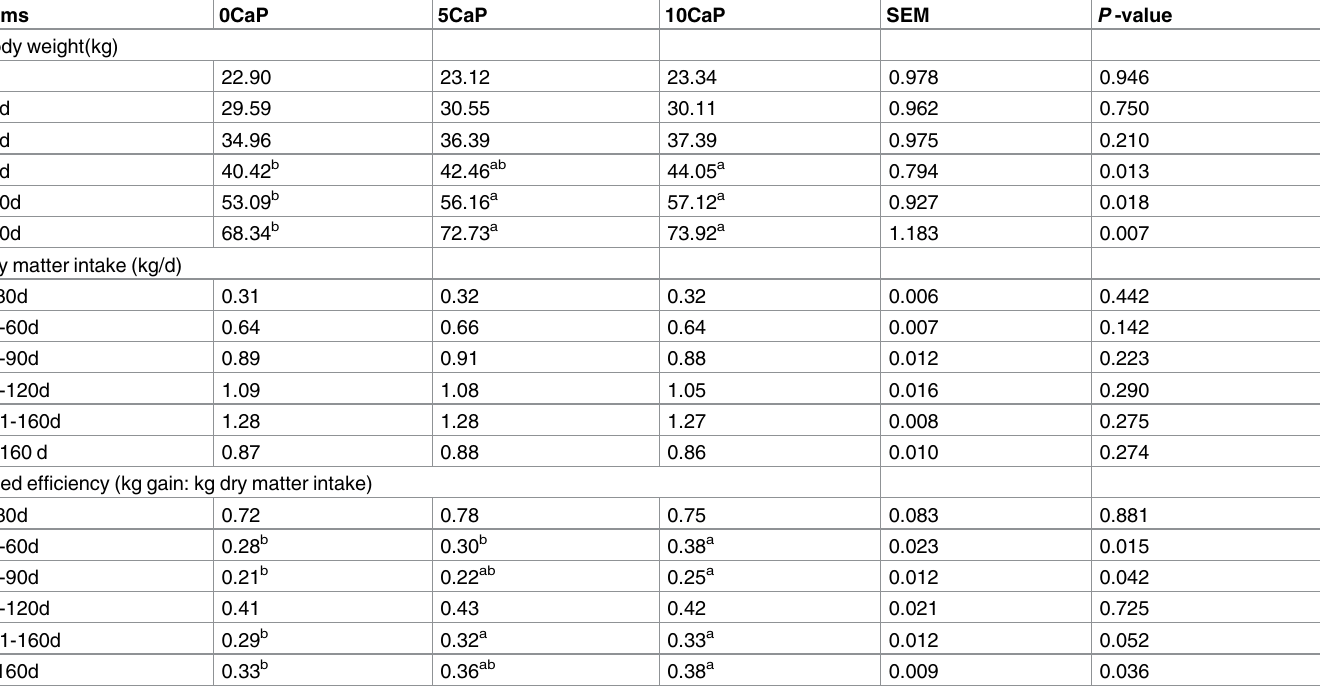
Table 2. The body weight, dry matterintake and feed efficiency of calves supplemented with calcium propionate at various stages of growth